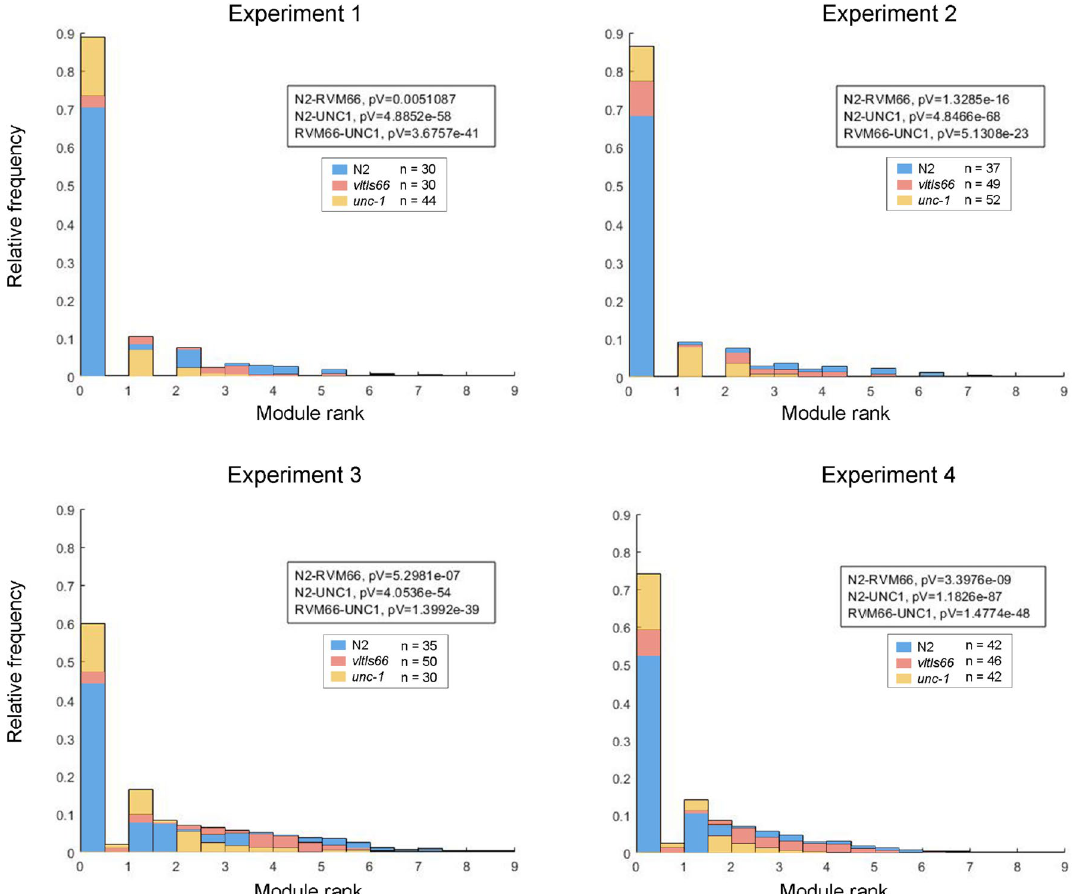
Figure 9. Relative frequency of module values. The abscissa axis represents the module value rank. The units are in steps, which in millimetres are 1.09 µ m / step . The blue bars are Wild Type (N2) strain, the orange bar is vltIs66[unc-25p::144CAG] strains and the red one is unc-1(vlt10) strain. The plot was drawn with the ’bar’ function of MATLAB